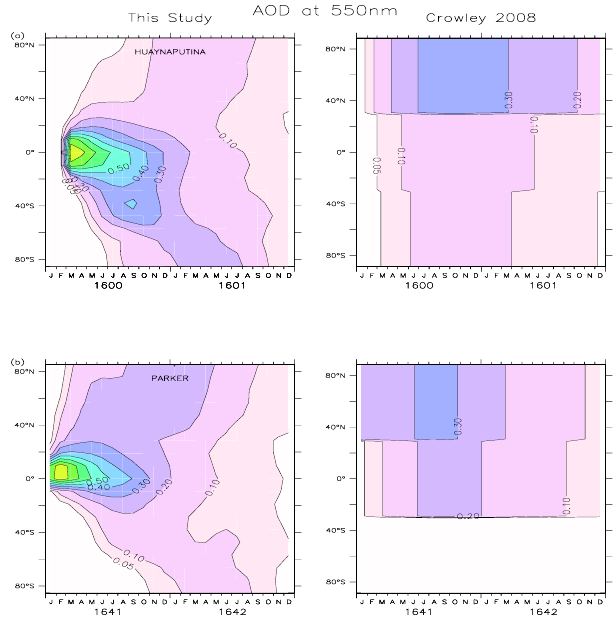
Fig. 4. Latitudinal distribution of the optical depth in VIS (550nm) for the Huaynaputina (1600) and Parker (1641) eruptions for this study (left column) and Crowley et al. (2008) (right column).